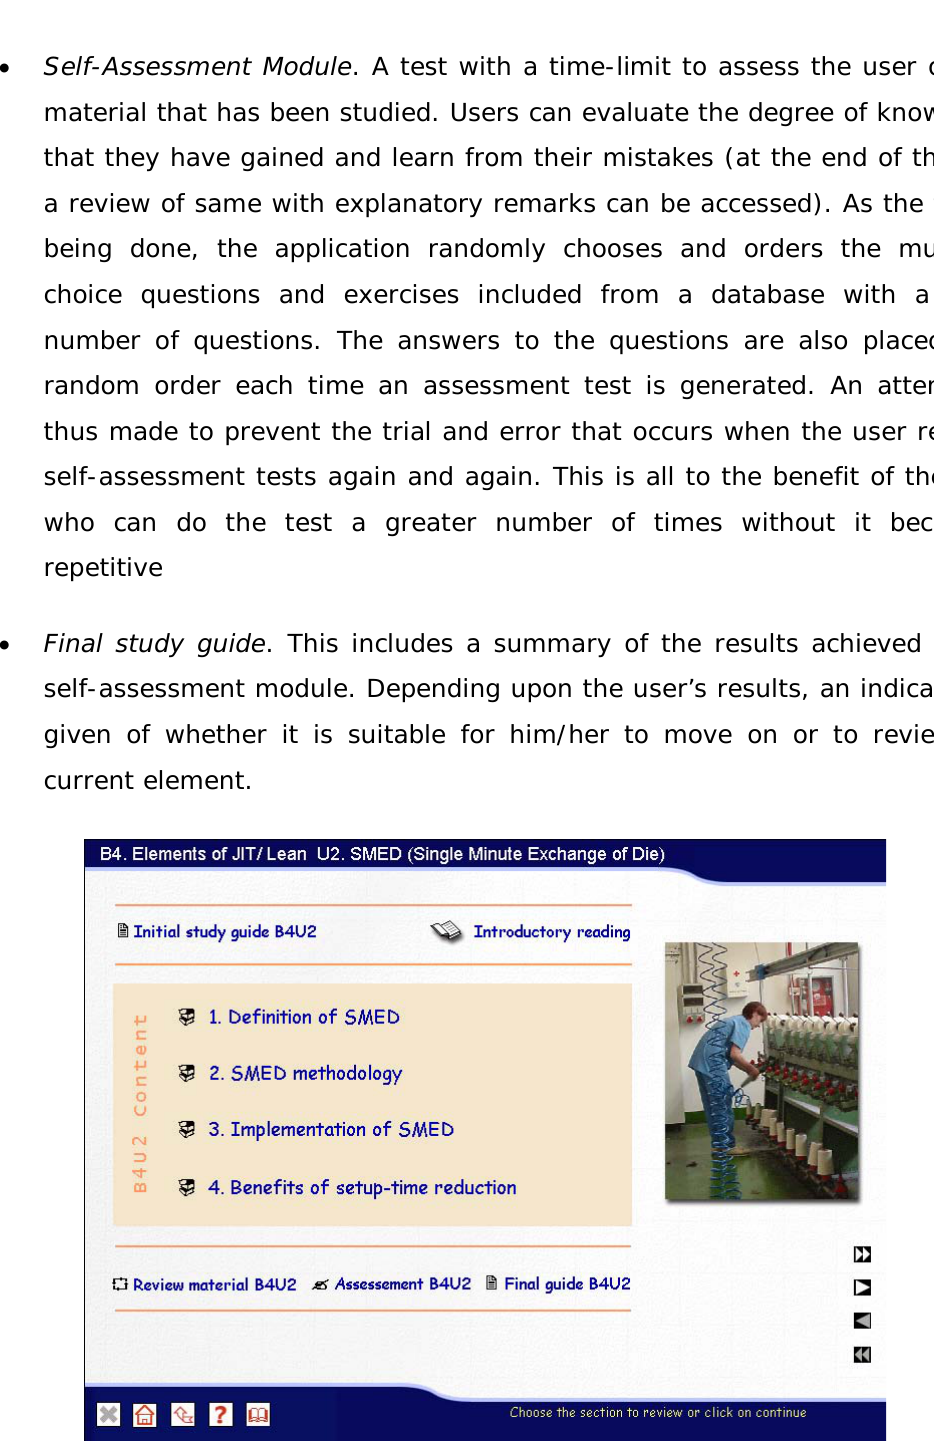
Figure 3. “Index screen for Block 4 Unit 2: SMED (Single Minute Exchange of Die)”. Having described the way the content and the elements that include blocks and units are organised, we now move on to an analysis of the remainder of